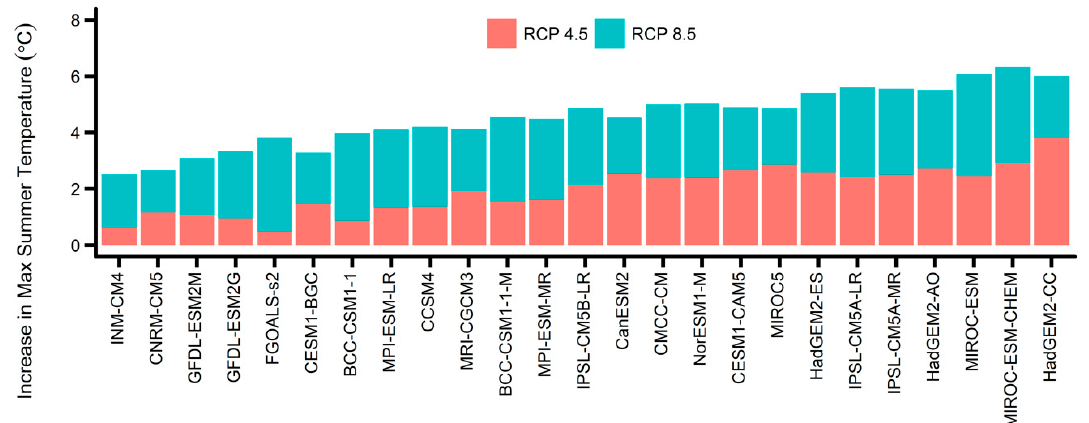
Figure 1. The average increase in maximum temperature under two Representative Concentration Pathways (RCPs) during summer time from the 2000s to the 2090s for each general circulation model (GCM), South Korea.